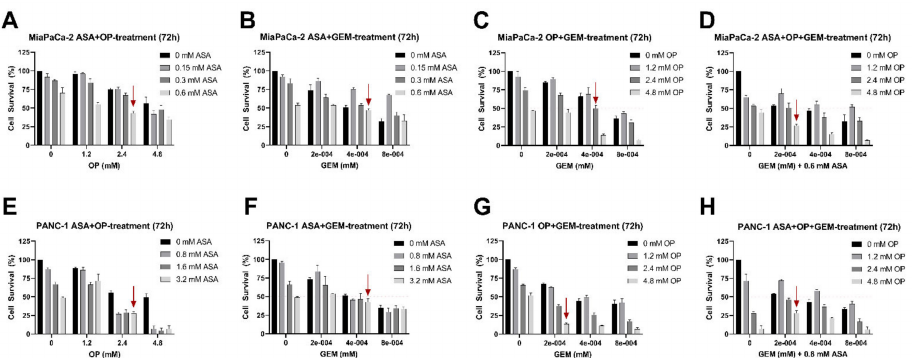
Figure 2. ASA, OP, GEM, and their combination reduce pancreatic cancer cell viability concentration- dependently. MiaPaCa-2 cells were plated in 96-well plates at 20,000 cells/well and treated with combinations of ( A ) ASA+OP, ( B ) ASA+GEM, ( C ) OP+GEM, ( D ) ASA+OP+GEM at increasing con- centrations for 72 h. PANC-1 cells were plated in 96-well plates at a density of 20,000 cells/well and treated with increasing concentrations of ( E ) ASA+OP, ( F ) ASA+GEM, ( G ) OP+GEM, and ( H ) ASA+OP+GEM at increasing concentrations for 72 h. The red arrows represent the first combi- nation therapy that achieves cell viability of <50% at or below the single-agent IC 50 values. Data are presented as mean ± SEM compared to the untreated control at day 0. Data are represented as the mean ± SEM of 3 independent experiments performed in triplicates. Abbreviations: IC 50 , half-maximal inhibitory concentration; ASA, aspirin; OP, oseltamivir phosphate; GEM, gemcitabine; SEM, standard error of the